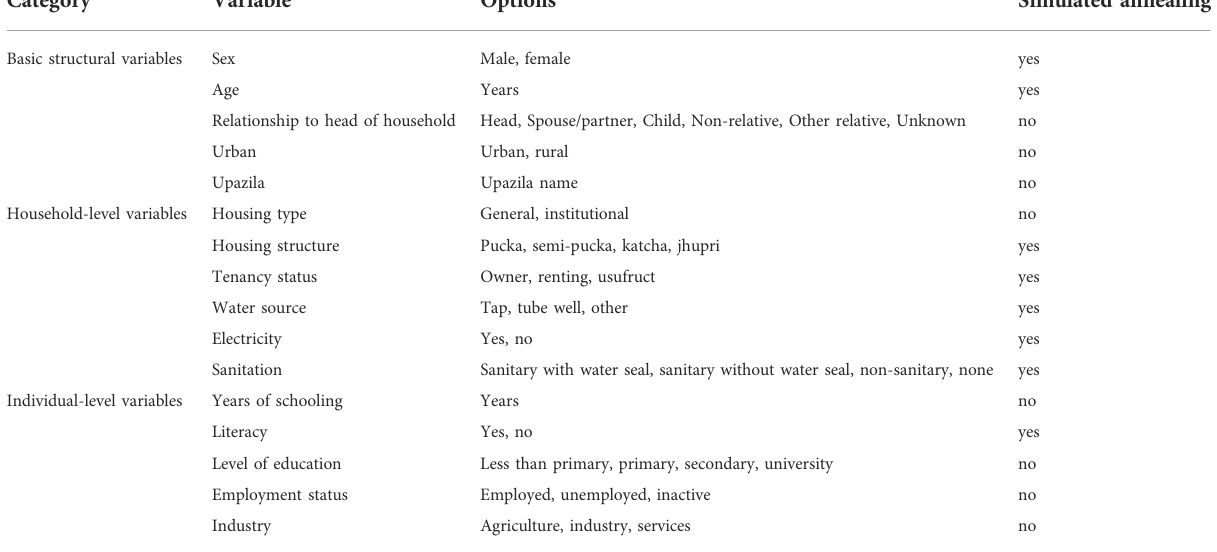
TABLE 1 Overview of the different variables in the synthetic dataset, including which variables are used in the calibration process using simulated annealing.